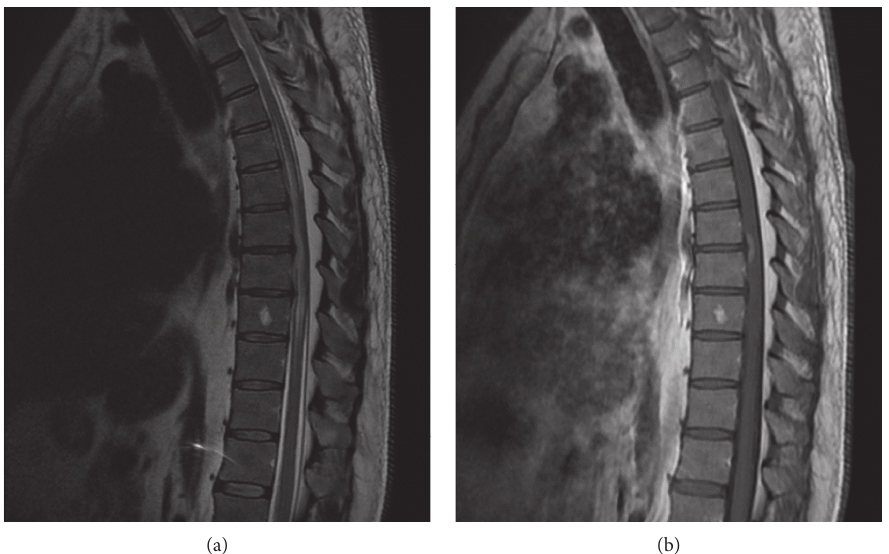
Figure 1: (a) Sagittal T2 MRI of dorsal spine showing high T2 signal with cord edema from T4 to T9 levels with thickened epidural fat tissue posteriorly. (b) Sagittal T1 MRI with gadolinium of dorsal spine showing an enhancing lesion at T7-T8 level.